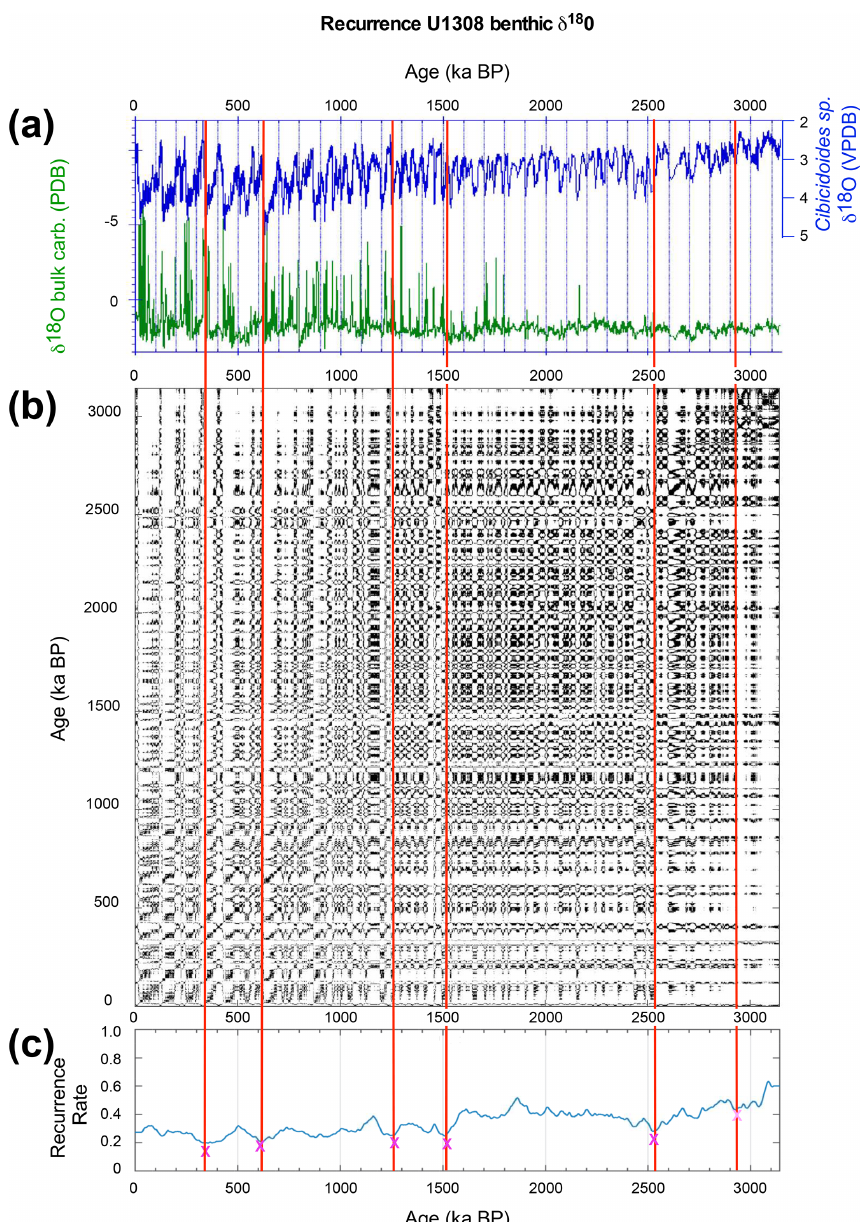
Figure 2. Recurrence analysis of the δ 18 O record in U1308 Cibicidoides sp. (Hodell and Channell, 2016a). (a) Time series of the Cibicidoides sp. δ 18 O (blue curve, top) and of the bulk carbonate δ 18 O (magenta curve, bottom). (b) Recurrence plot (RP) where the proximity threshold is (cid:49) ( δ 18 O) = 0 . 2‰. (c) Recurrence rate (RR) with significant values labeled with a red cross; RR close to the threshold is marked in pink. Vertical bars represent the major transitions (5 + 1) determined by the analysis. The RP website is http://www.recurrence-plot.tk/ (last access: 8 February